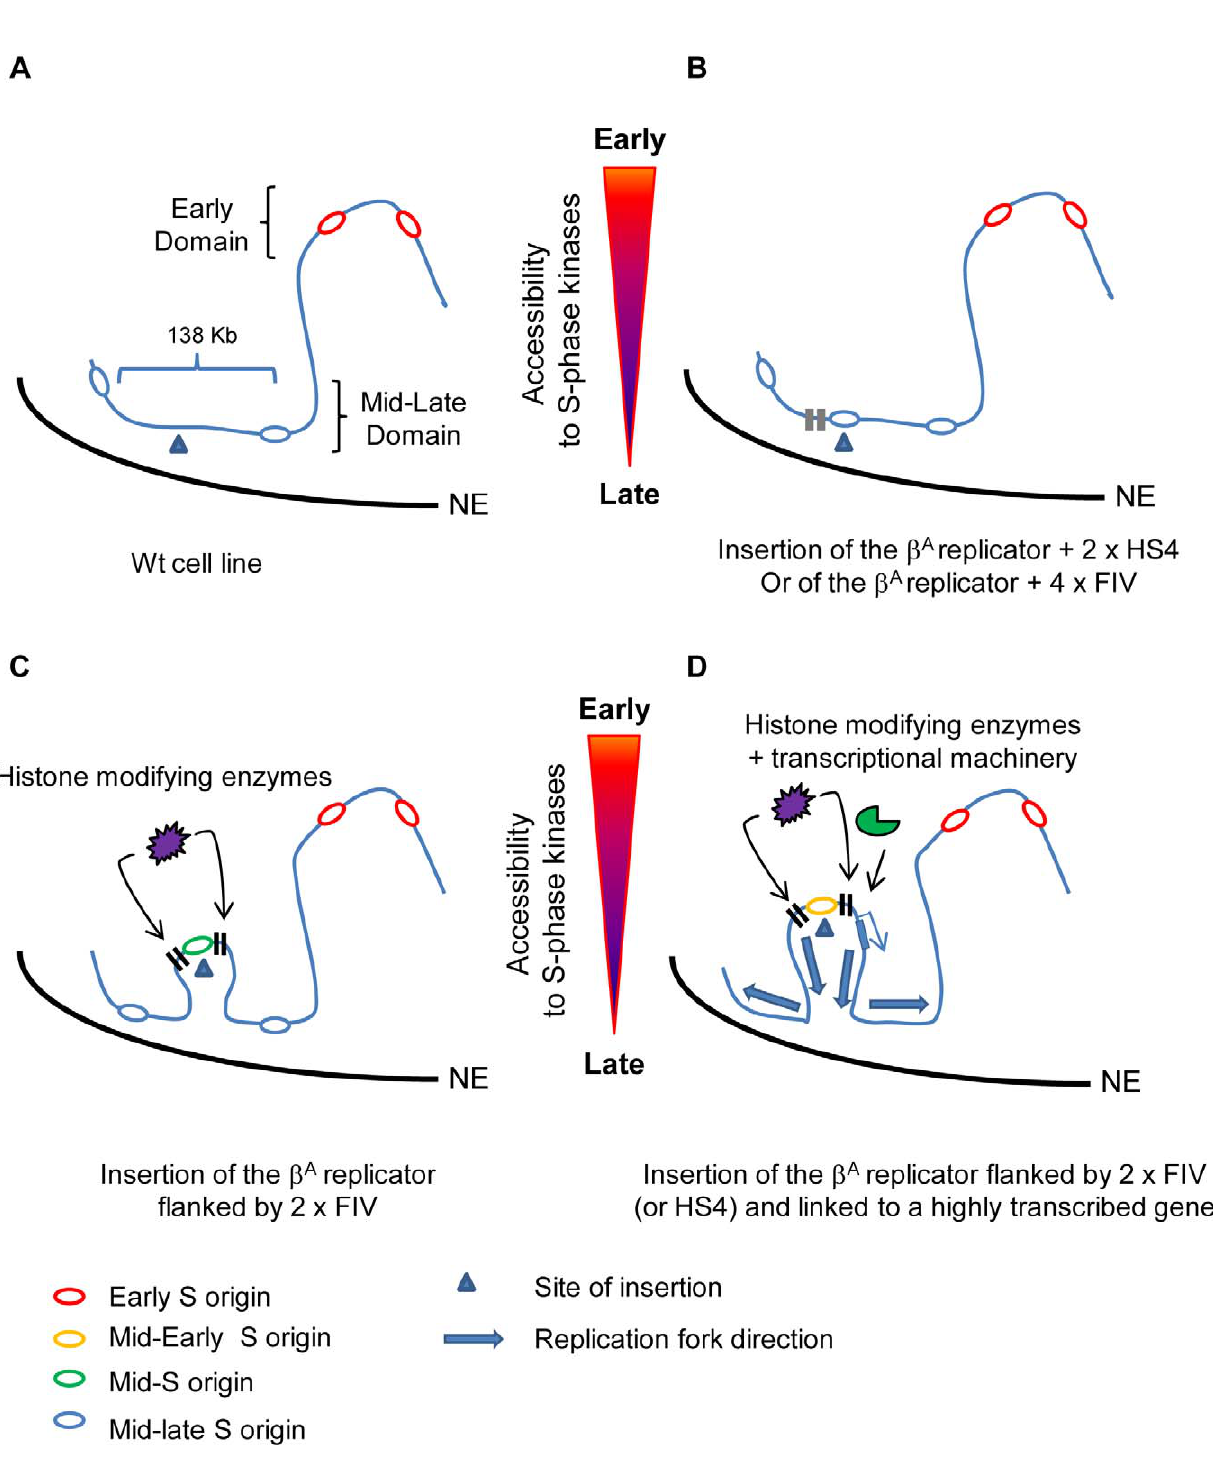
Figure 11. Role of cis -regulatory element in controlling replication timing. (A) In wt DT40 cells, the selected site of insertion is located in a mid-late replicating region devoid of strong replication origin. One hypothesis is that this locus is naturally located more toward the nuclear envelope (NE). (B) Insertion of a strong replicator linked to two copies of the HS4 insulator or four binding sites for USF (FIV) does not induce a replication timing shift. The replication timing of the transgenic replicator follows that of its chromosomal environment. (C) Flanking the strong replicator with two copies of FIV induces a significant replication timing shift and recruitment of histone modifying enzymes. This could be accompanied by the formation of a small loop that relocates the replicator more toward the interior of the nucleus. The increased accessibility to S-phase kinases could be either due to local decondensation of the chromatin structure and/or to the nuclear repositioning of the modified chromosomal region. (D) The addition of a strong promoter nearby increases the replication timing shift and leads to the formation of an independent mid-early replicon. doi:10.1371/journal.pbio.1001277.g011 PLoS Biology |